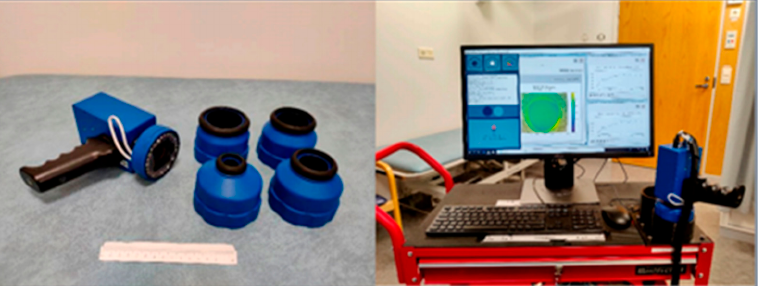
Figure 5. SICSURFIS handheld hyperspectral imaging system [40]. The article [66] describes the principle and testing of the first phase of a three-stage pilot of this imaging system, focused on the intricate skin surface. The device is still a prototype and ongoing refinement is needed before it can be used for clinical applications.